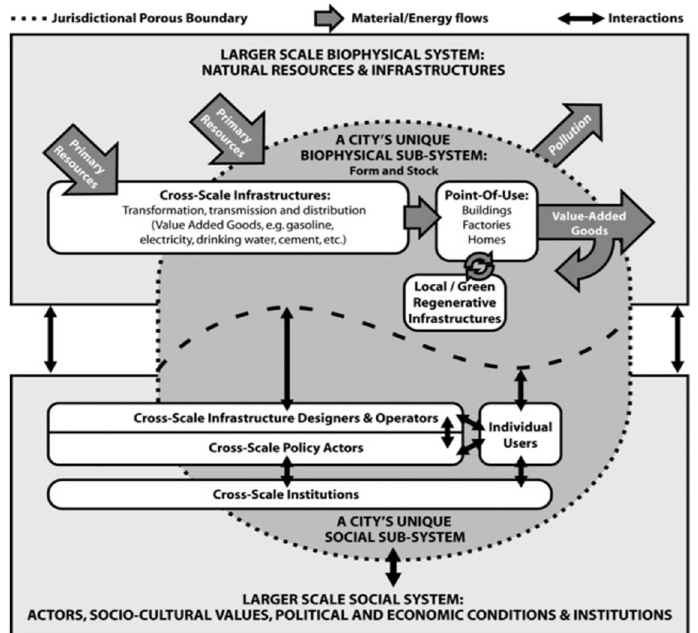
Figure 2. Schematic representation of the social ‐ ecological ‐ infrastructural systems or SEIS [8].